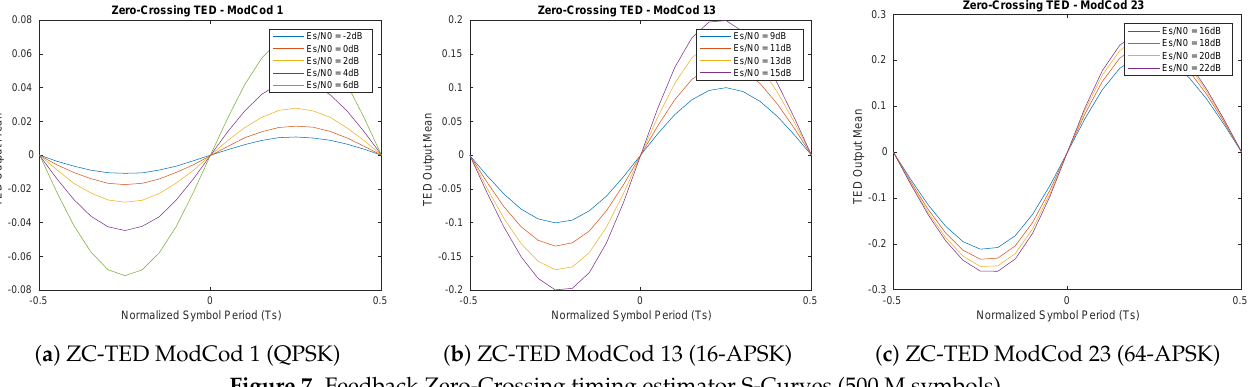
Figure 7. Feedback Zero-Crossing timing estimator S-Curves (500 M symbols).